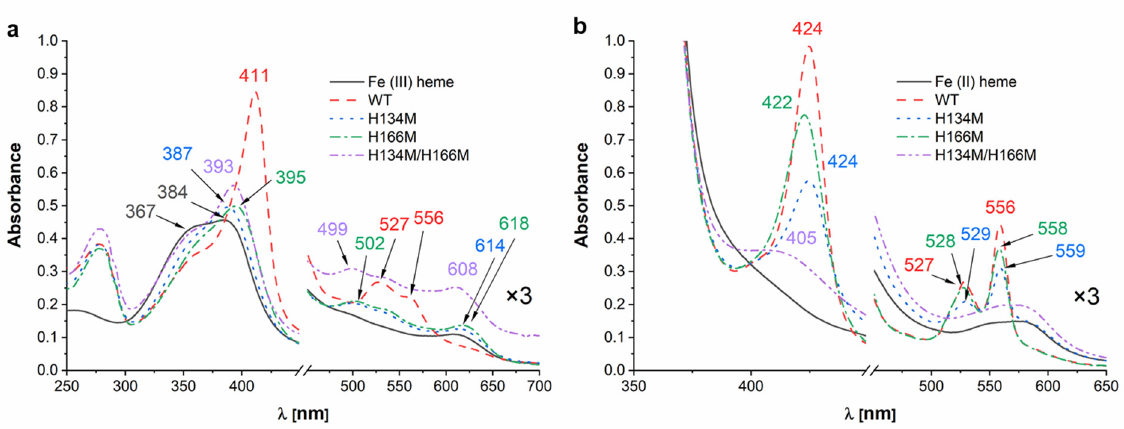
Figure 4. Analysis of heme binding to the site-directed mutagenesis HmuY variants. UV-visible absorption spectra of proteins in complex with heme (1:1 protein:heme ratio) recorded under ( a ) air (oxidizing) conditions or ( b ) reducing conditions formed by addition of sodium dithionite. Absorbance spectra at Q band region magnified three times ( × 3).